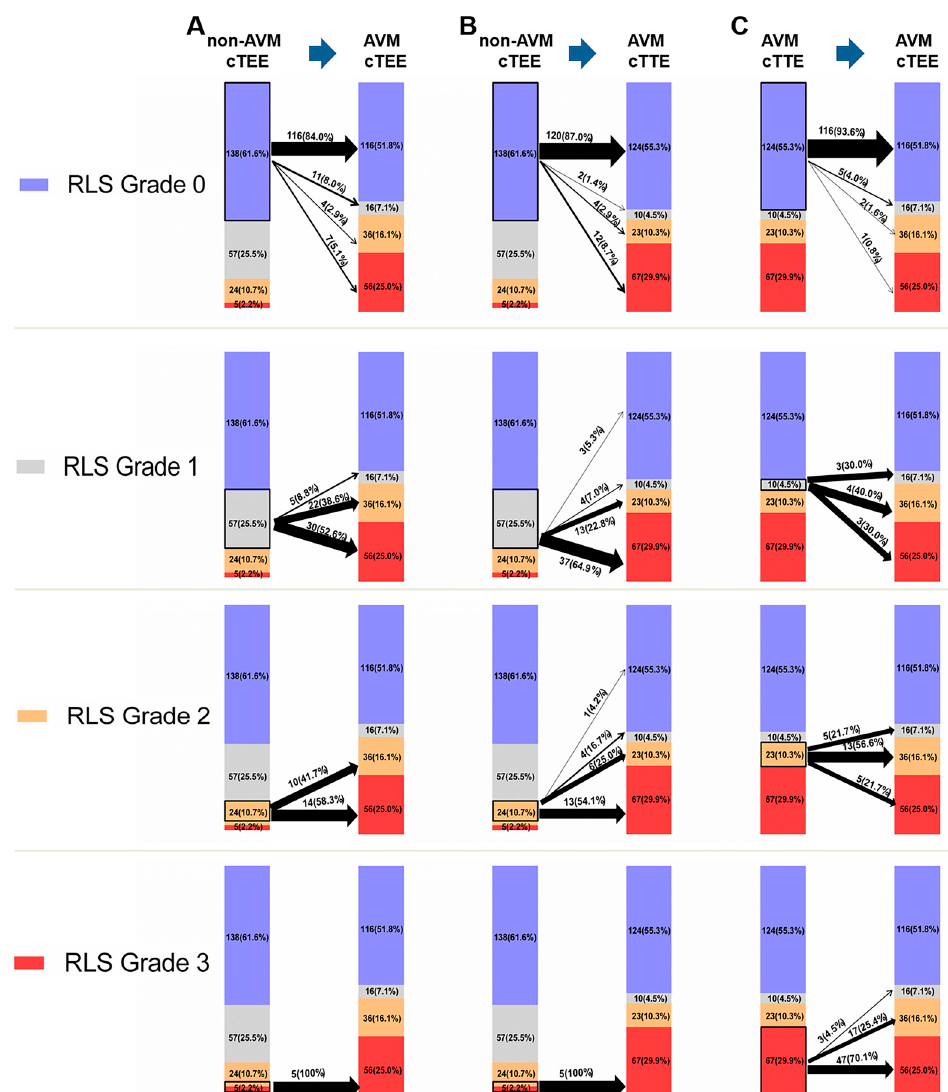
Figure 4. Reclassification between each RLS assessed by different conditions to determine RLS Grade 0, Grade 1, Grade 2, and Grade 3. The widths of arrows identify reclassification rates. ( A ) Initial classification by non-AVM cTEE reclassified by AVM cTEE. ( B ) Initial classification by non-AVM cTEE reclassified by AVM cTTE. ( C ) Initial classification by AVM cTTE reclassified by AVM cTEE. RLS, right-to-left shunt; AVM, adequate Valsalva maneuver; cTTE, contrast-enhanced transthoracic echocardiography; cTEE, contrast-enhanced transesophageal echocardiography.